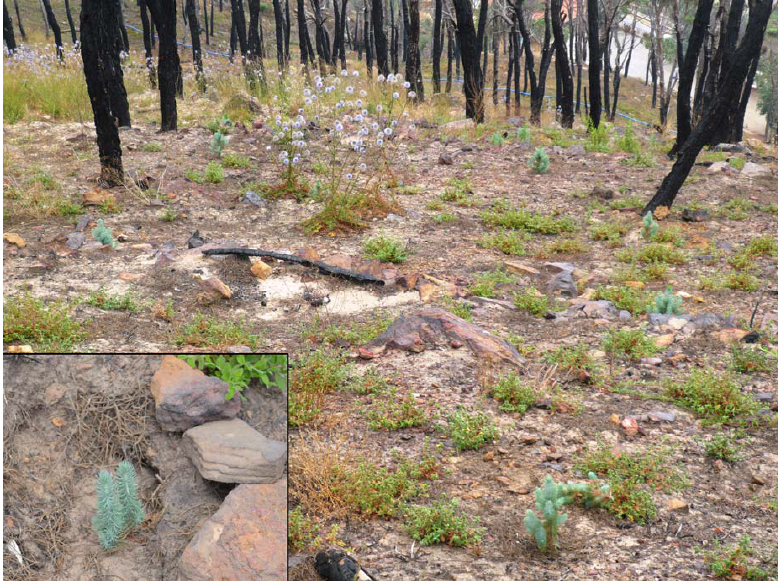
Figure 9. Stone pine planted at Wadi Al-Karm, Lebanon. 100% of 8-month seedlings survived after 1 year; survival from seeds was 72%. Inset shows 2 of 3 seeds planted in a spot that have germinated and